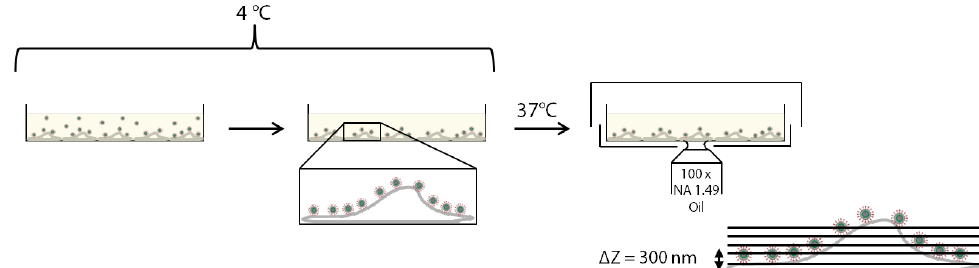
Figure A2. Sample preparation and data acquisition. Precooled HeLa cells were incubated double-labeled FV particles at 4 °C to allow membrane attachment and synchronize uptake. Immediately after transferring the sample onto the 37 °C warm microscope stage virus uptake was monitored by acquiring z -stacks of single cells decorated with not more than approx. 40 particles for a total time of about 20 min.